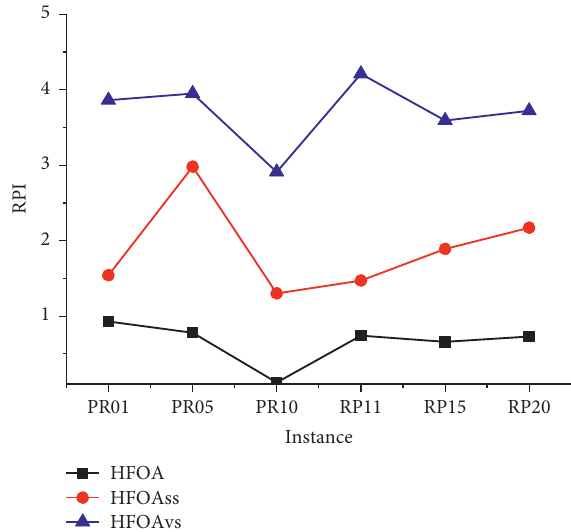
Figure 9: Comparison of smell and vision